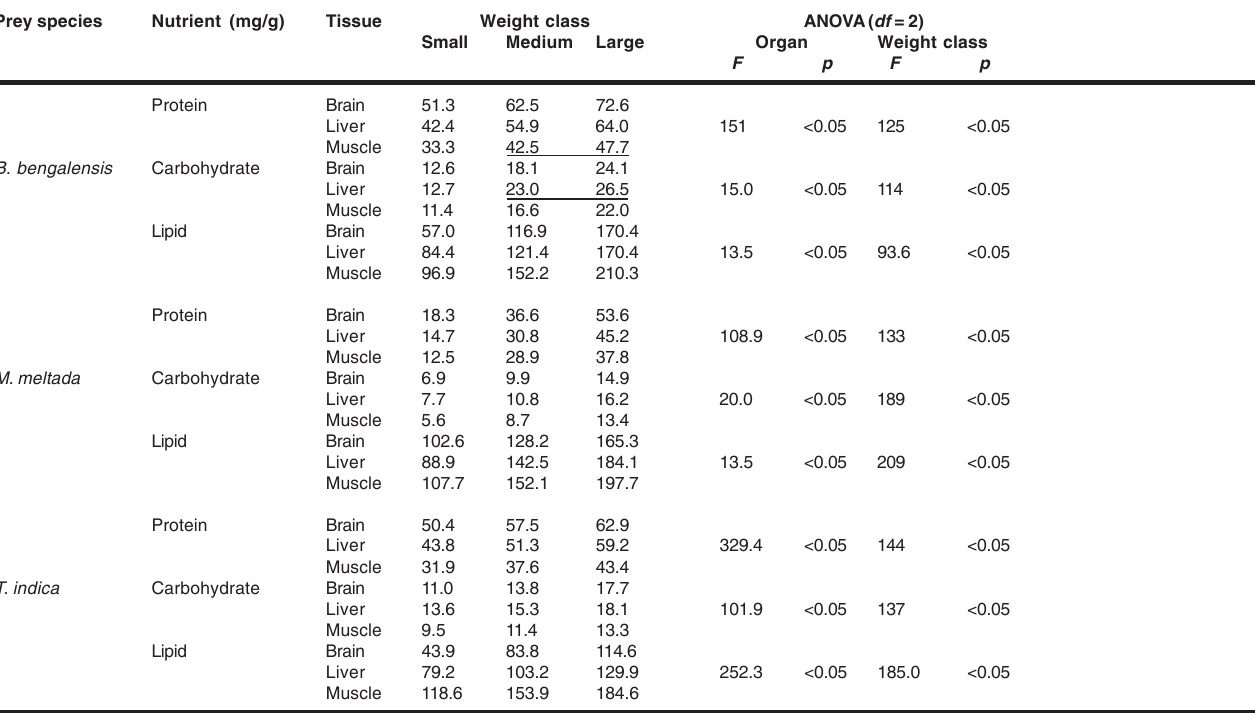
Table 5. Nutrient contents (mg/g) in the brain, liver and muscle of the three weight classes of the three prey species (horizontal lines connect similar means (Least Significant Difference (LSD) was used for comparison) and results of two- way ANOVA show the effect of organ types and weight classes on the three nutrients levels Prey